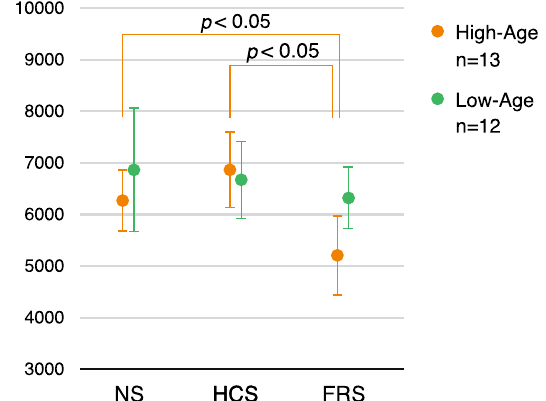
Figure 3. Incremental area under the curve (iAUC) for the three sound conditions for the participants grouped by age. Orange indicates the mean and the standard error of mean of 13 participants in the high-age group and green indicates those of 12 participants in the low-age group. Mean age of high-age and low-age groups was 63.3 (59–69) years and 51.3 (42–57) years, respectively. iAUC was significantly smaller in the full-range sound condition than in both the no sound and high-cut sound conditions in the high-age group, whereas this tendency was not observed in the low-age group.